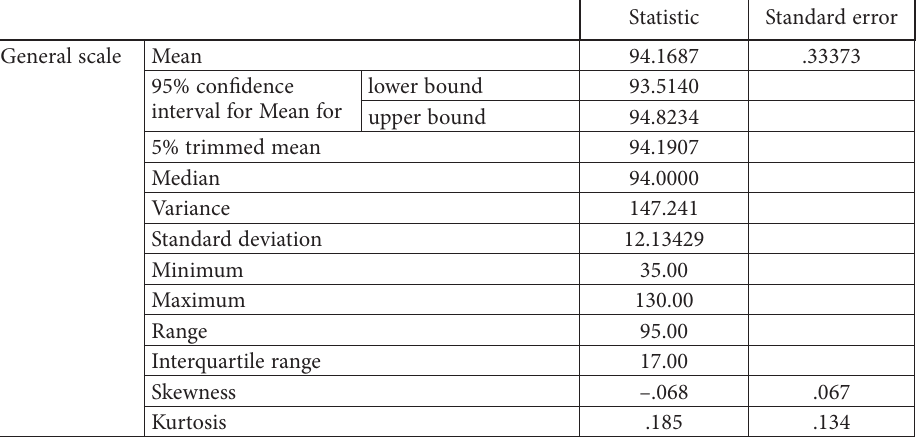
Table 3. Coefficients of excess and asymmetry for the variable general scale. Descriptives (source: cre- ated by